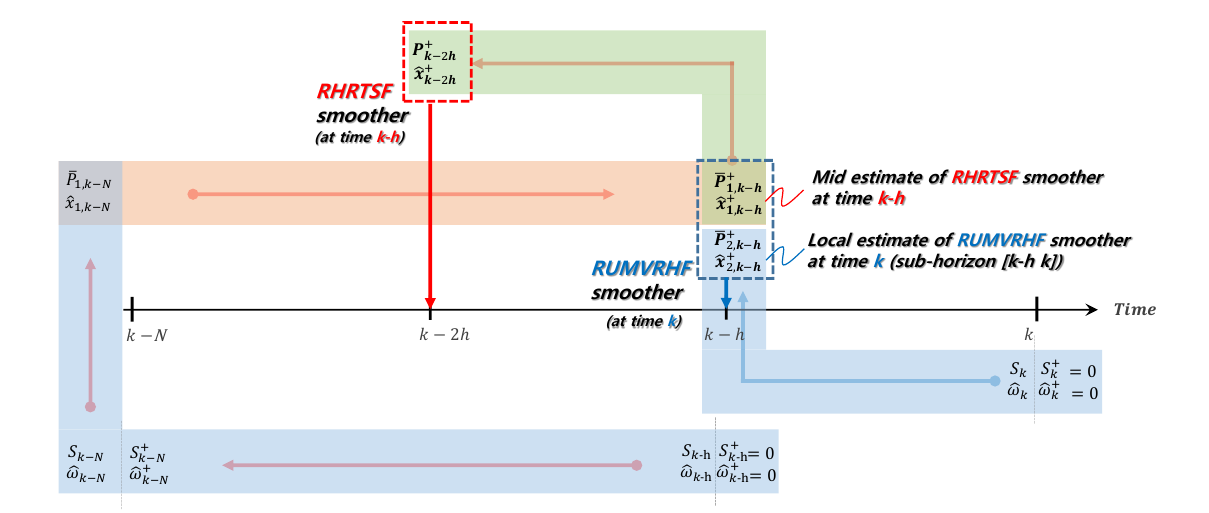
Figure 3. The concept of RCCRHF